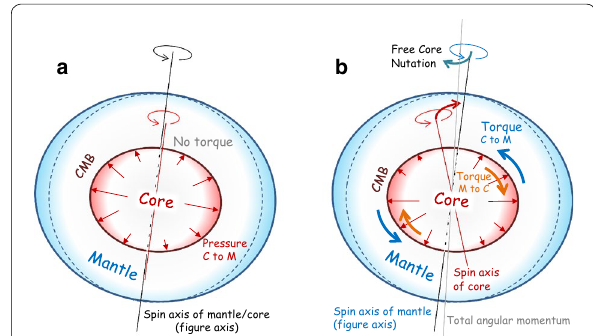
Fig. 4 Inertial core–mantle coupling and excitation of free core nutation (FCN). Pressure at the core–mantle boundary (CMB) (red arrows) does not exert a torque if the rotation axis of the mantle and the core are coincident ( a ). Deviation from this state let the pressure at CMB make opposite torques to the mantle (blue arrows) and to the core (orange arrows) ( b ). This causes FCN, i.e., rotational movements of the spin axes of the mantle and the core relative to stars in the opposite directions